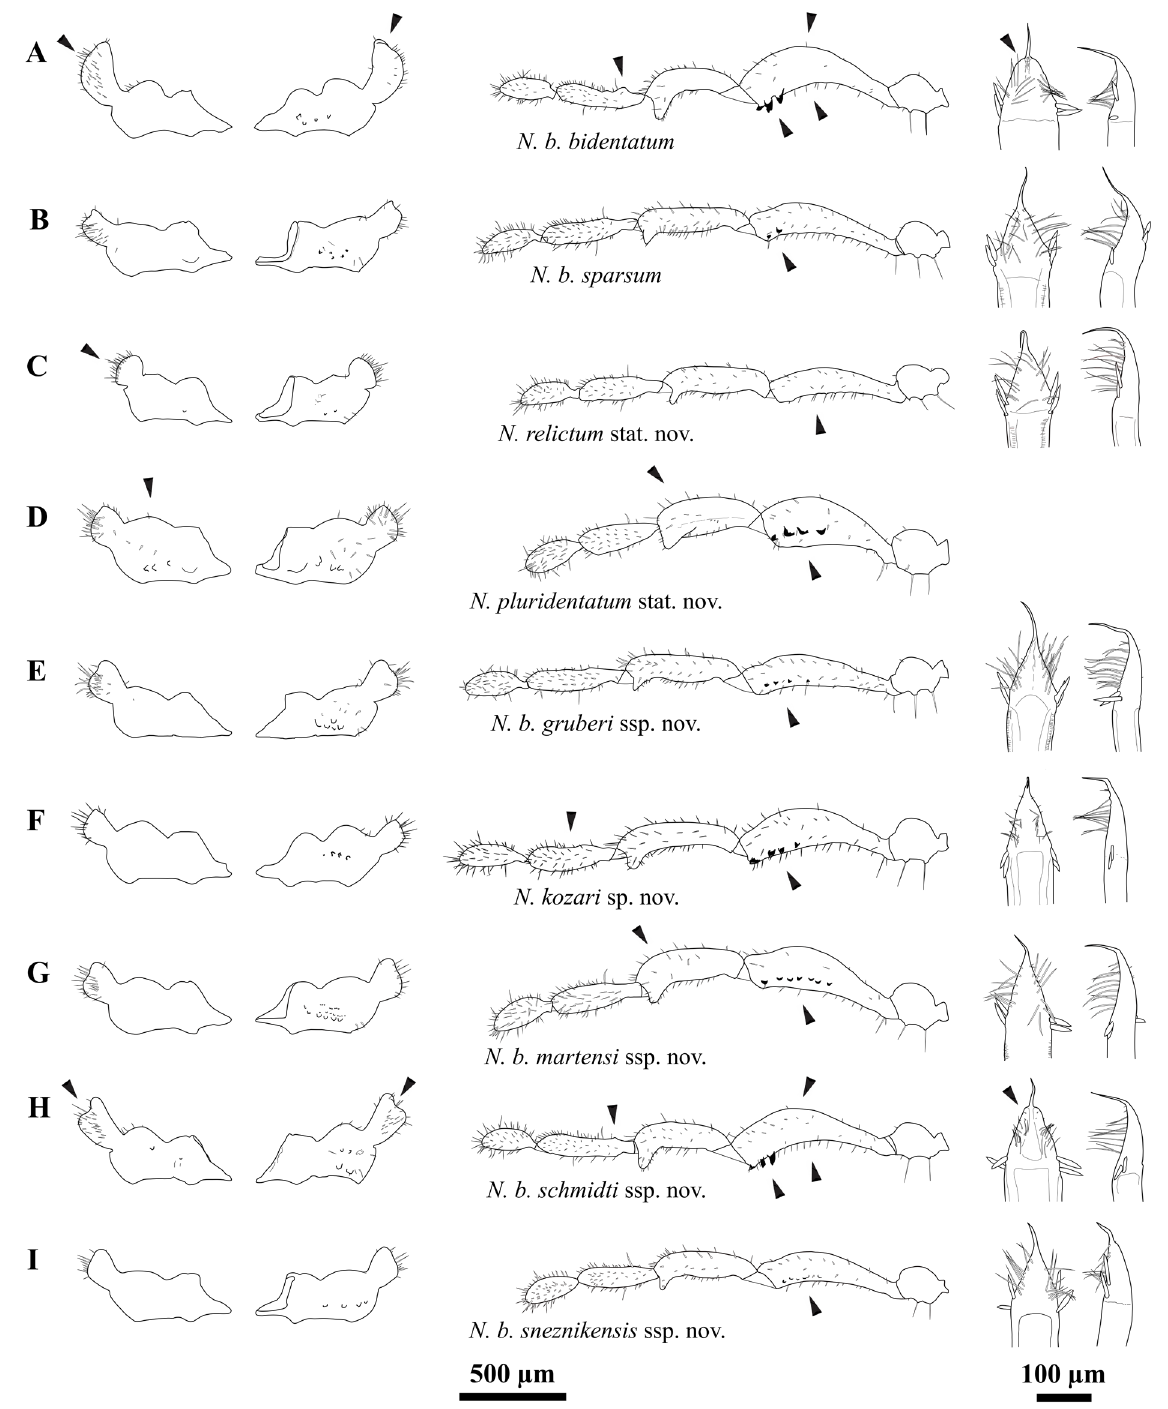
Fig. 12. Nemastoma bidentatum Roewer, 1914 complex, ♂♂. From left to right: Ch basal article (medial, lateral views), Pa (medial view) and Pe tip (dorsal, lateral views). Arrows indicate the most identifying characters. Note: Pe of N. pluridentatum (Hadži, 1973) stat. nov. is